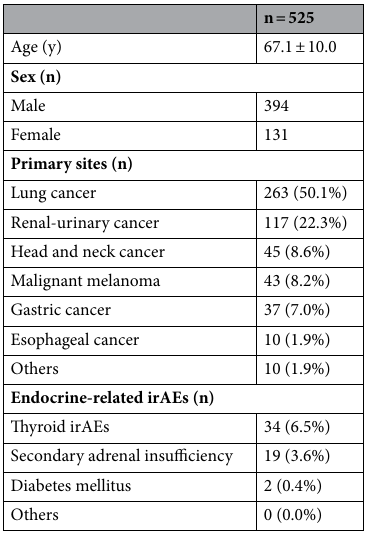
Table 1. Characteristics of the overall cohort. Age is expressed as average (± standard deviation) at the first administration of immune checkpoint inhibitors. Abbreviation: irAEs immune-related adverse